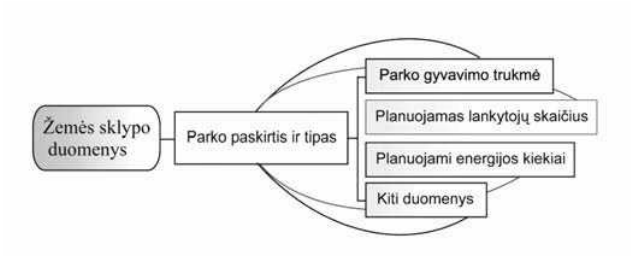
4 pav. Pradinis projektavimo etapas Fig 4. Primary stage of